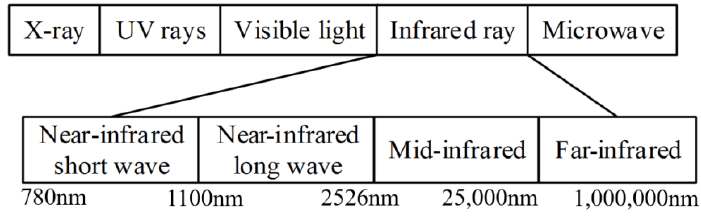
Figure 2. Near-infrared spectral region diagram.